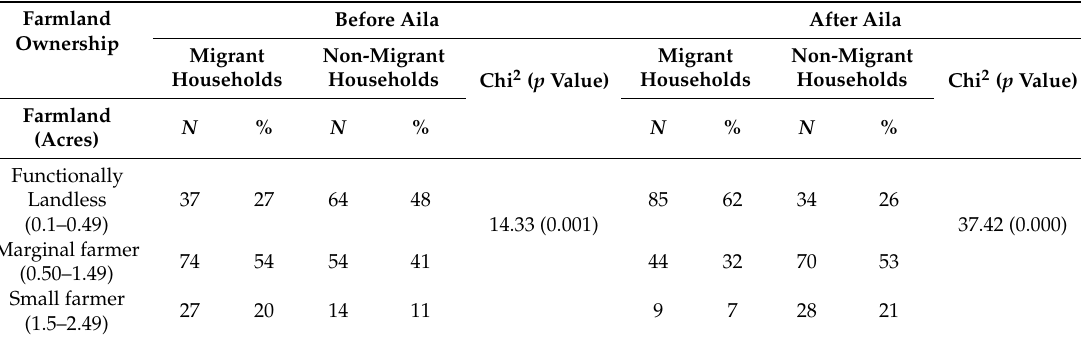
Table 14. Farmland ownership of the households—before and after Aila.